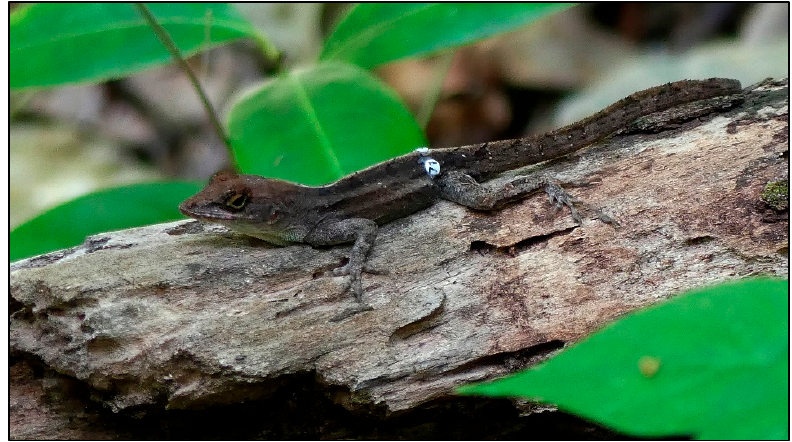
Figure 2. Adult male Anolis homolechis marked with a numbered temporarily tag.